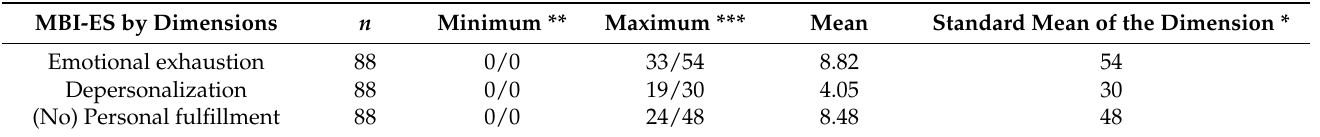
Table A5. Means and standard deviations of the MBI-ES scale by dimensions (taking the test totals). Source: own